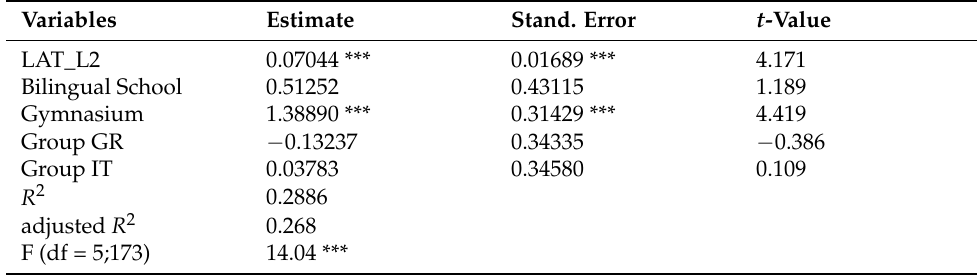
Table A4. Effects of LAT scores, school type and language group on text competence